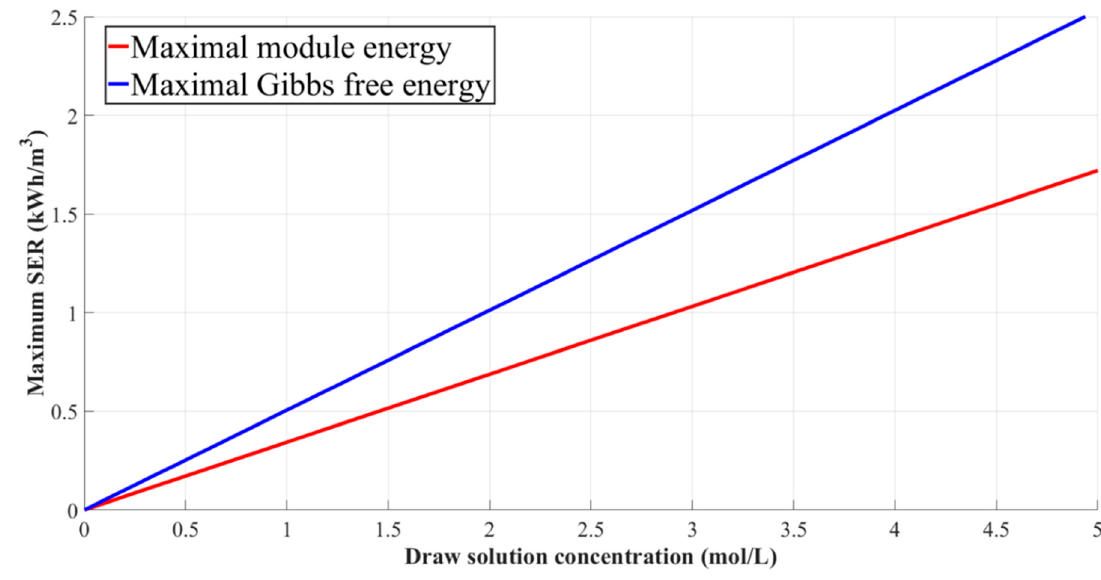
Figure 11. The comparison of maximal specific energy extracted from the mixing process between the feed solution and the draw solution of a PRO process. The blue line indicates the maximal SER harvested under an ideal condition, ∆ G MAX . The red line indicates the maximal SER harvested under counter-current module conditions, SEP MAX , module . The figure was redrawn by the authors of the current review based on References [12,14].